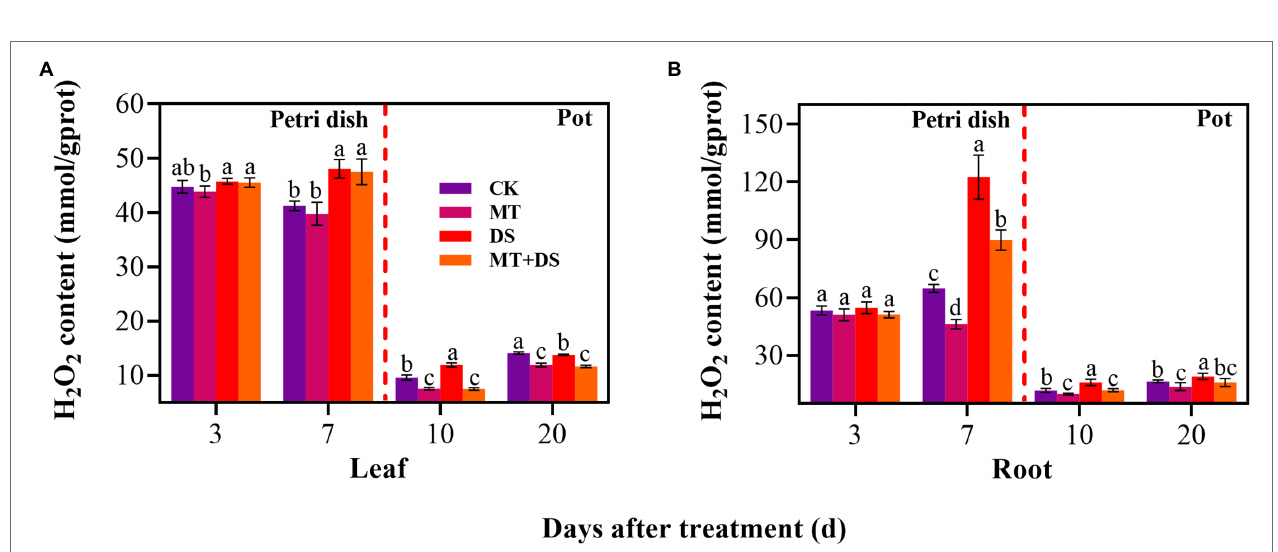
FIGURE 9 | In Petri dish, 20 μ M MT was used as the optimal priming treatment for triticale seeds priming (MT), 0 μ M MT as normal treatment (CK), 10% PEG as drought treatment (DS), and 20 μ M MT + 10% PEG treatment (MT+DS). In pot, 20 μ M MT was used as the optimal priming treatment for triticale seedlings, unprimed +70–75% relative water content as CK, primed +70–75% relative water content as MT, unprimed +40–45% relative water content as DS, and primed +40–45% relative water content as MT+DS. (A) H 2 O 2 content of triticale seeds germinated in Petri dishes on 3 rd and 7 th days and potted seeding leaves on 10 th and 20 th days; and (B) H 2 O 2 content in radicle of triticale seeds germinated in Petri dish on 3 rd and 7 th d and seedling roots on 10 th and 20 th days. For each trait, bars with the same letter are not significantly different ( p < 0.05). Different lower letters indicate significant differences among the treatments ( p < 0.05). Data shown are the averages ± SE ( n = 6 in A,B